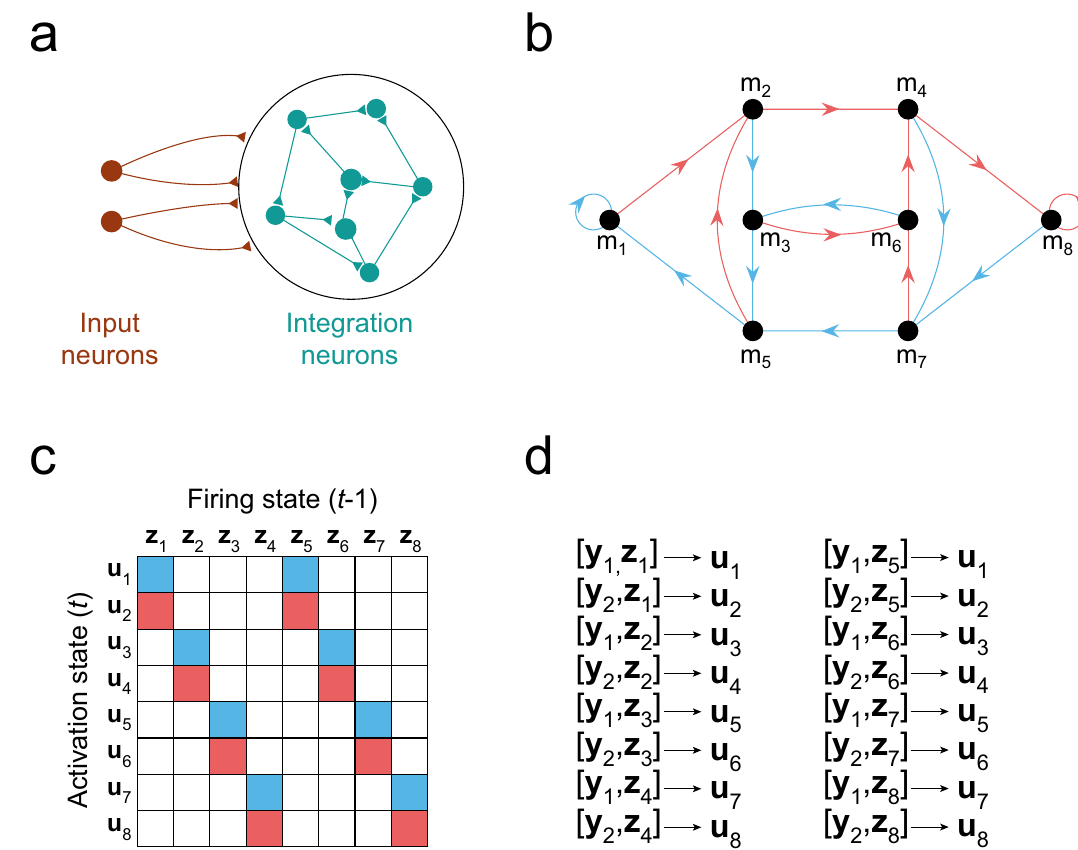
Figure 1. Constructing recurrent networks that follow a predefined transition graph. ( a ) Networks are composed of binary neurons. Input neurons codify stimuli and project to the integration neurons through synaptic weights W in . Integration neurons are recurrently connected through synaptic weights W rec . ( b ) Transition graph showing transitions between network states during execution of the s-task, for τ = 3 . Each node in the graph is a network state, and the directed edges depict transitions between states after stimuli presentation (blue for s 1 , red for s 2 ). Each possible sequence of 3 stimuli is codified by exactly one network state. Nodes are numbered such that transitions can be represented in a simple transition matrix. ( c ) Transition matrix associated with the transition graph in panel ( b ). It shows the activation states u that are reached when integration neurons are in a population firing state z , and s 1 (blue) or s 2 (red) are presented. ( d ) Same transitions depicted in panels ( b ) and ( c ), but explicitly showing vectors u i and vectors c i , which are the concatenation of one y and one z . The index i is such that z i and u i are the firing state and activation vectors corresponding to network state m i